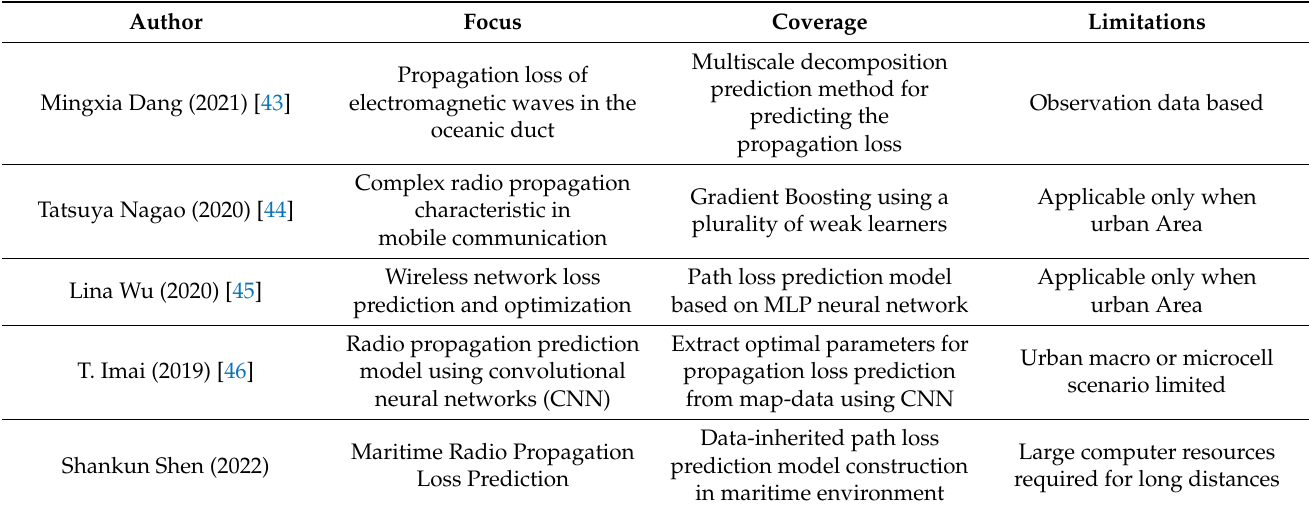
Table 1. The latest machine learning application on radio propagation